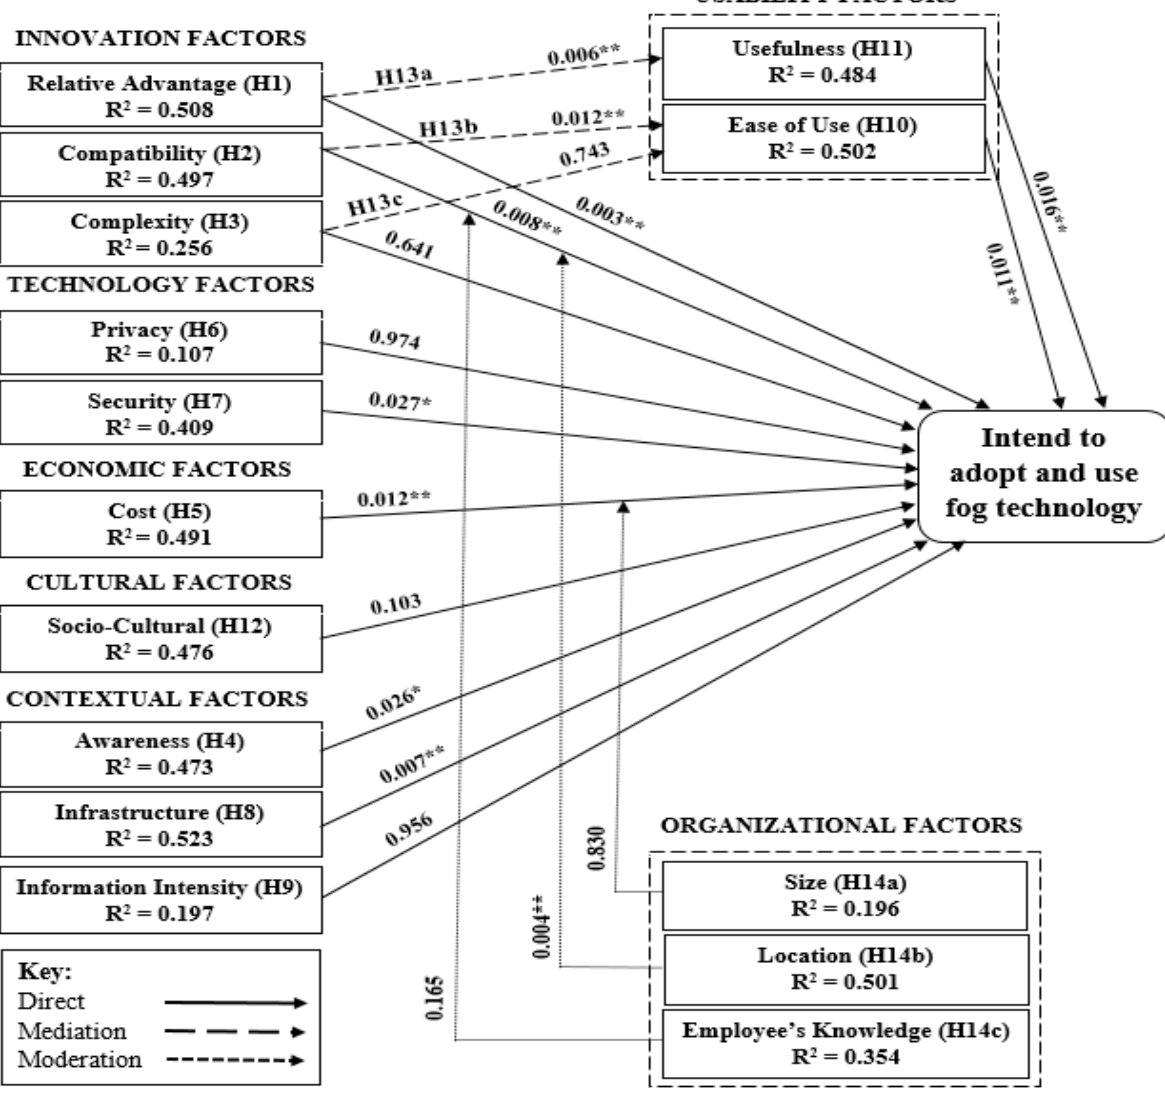
Figure 3. Fog technology adaption framework. * Significant at p < 0.05, ** Significant at p < 0.01.